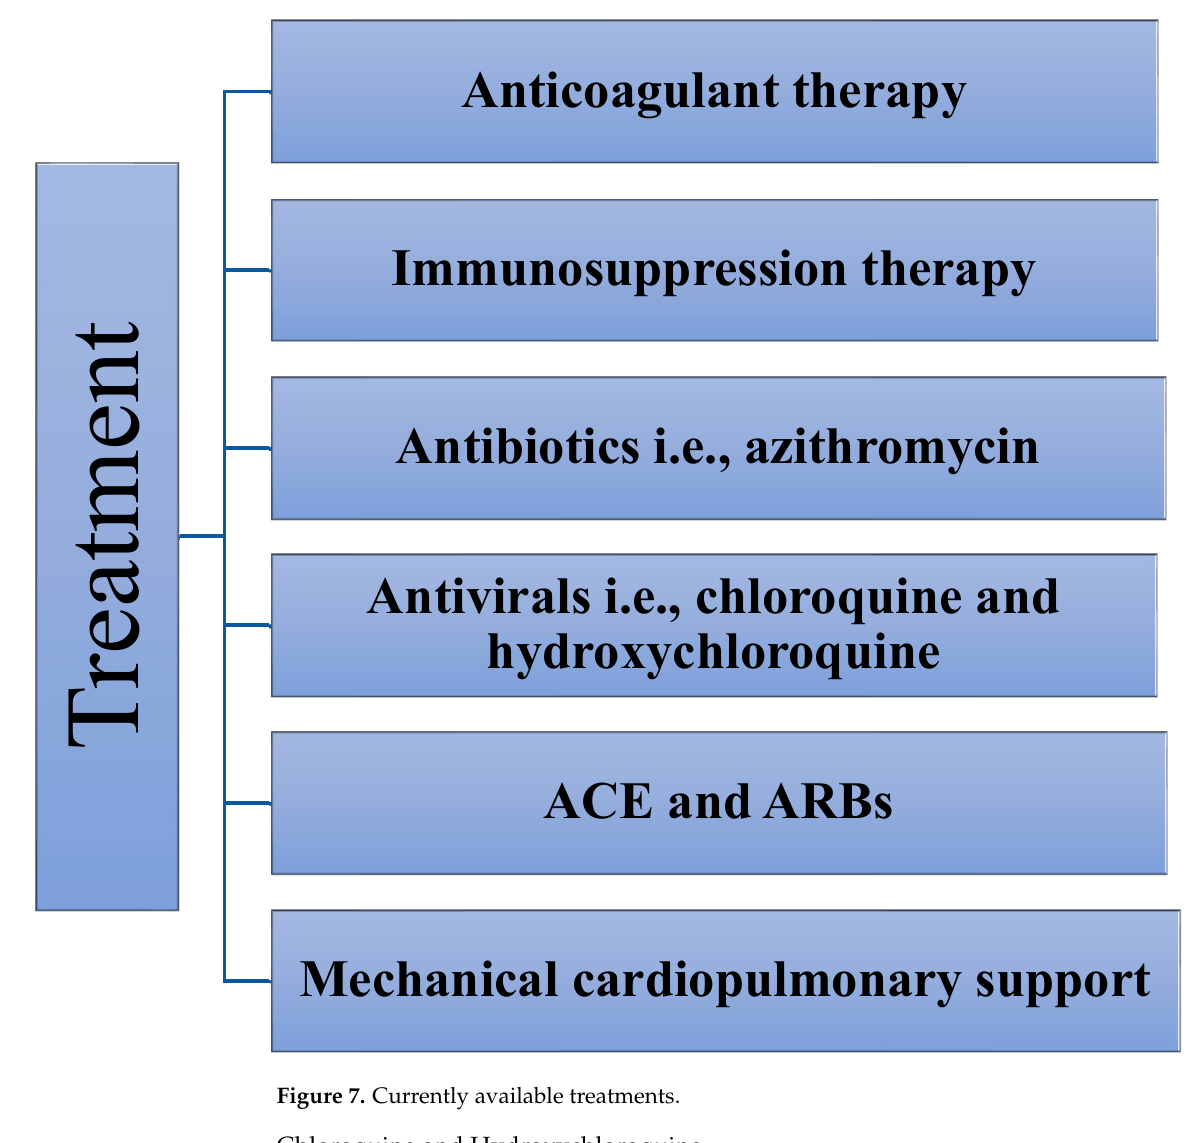
Figure 7. Currently available treatments.